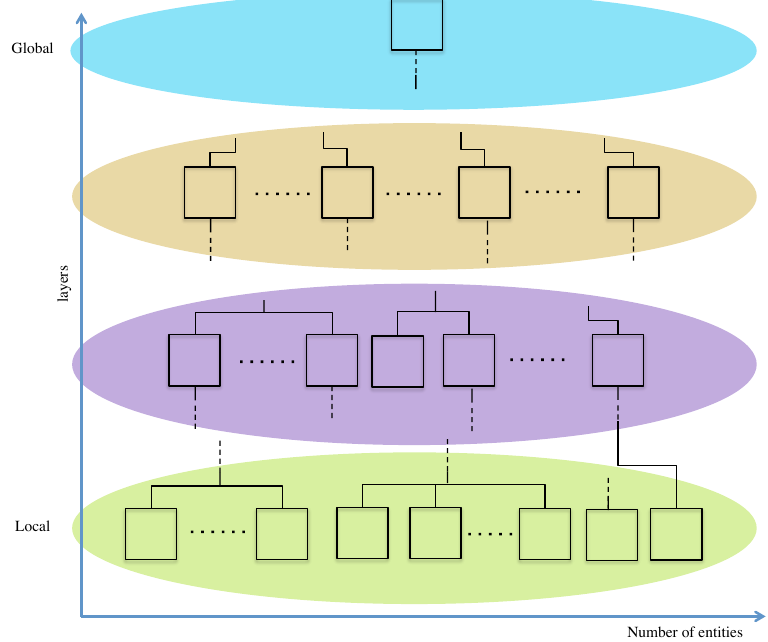
Figure 1. Generic layered architecture for a distributed smart